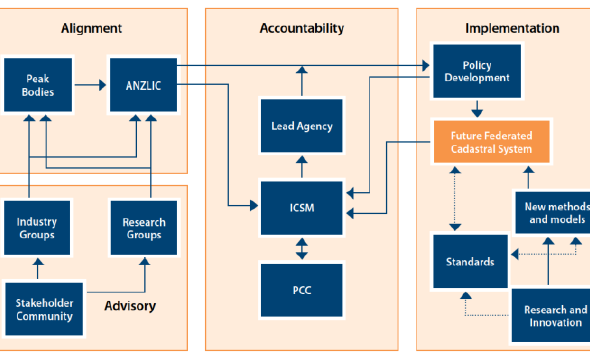
Figure 2 . Federated Cadastral System stakeholder framework (ICSM 2017)